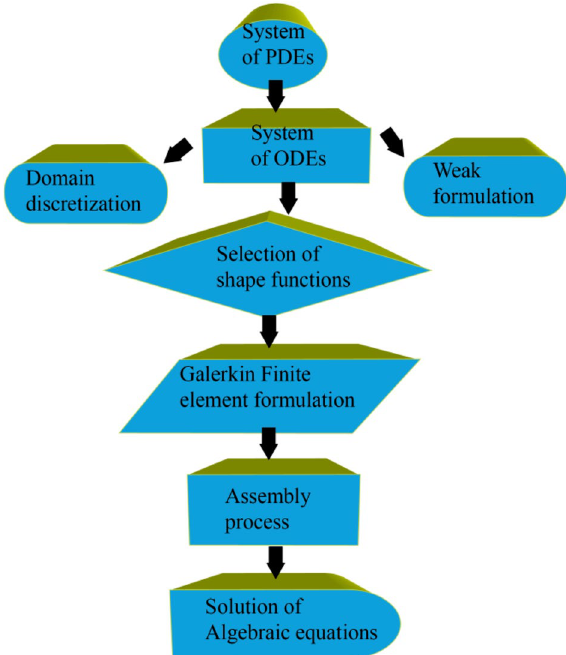
Figure 2. Flow chart of G-FEM.